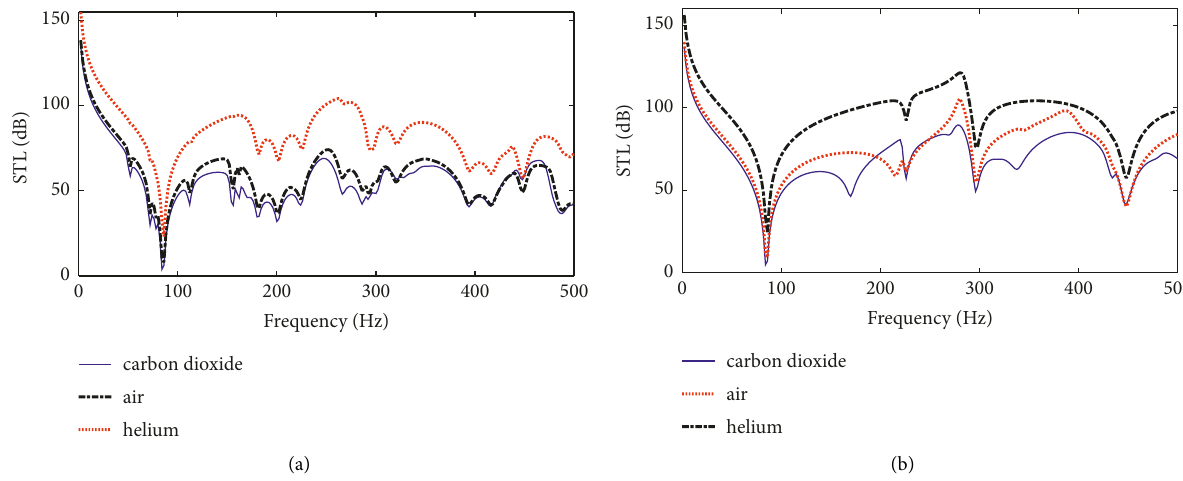
Figure 22: Sound transmission loss of the stiffened double panel-cavity coupled system with different acoustic cavity mediums: (a) acoustic excitation with elevation angle φ � π /4 and azimuth angle θ � π /4 and (b) acoustic excitation perpendicular to panel 1.